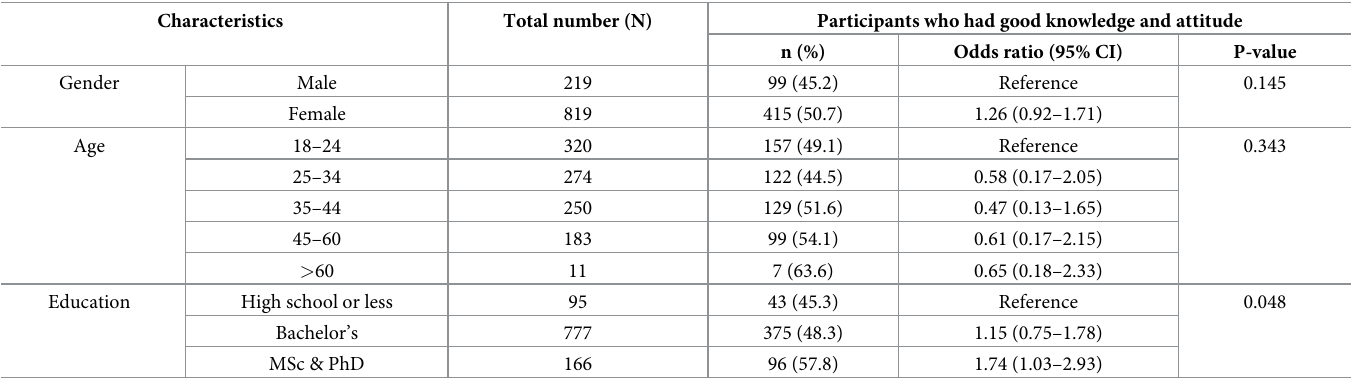
Table 3. Multiple regression analysis of the impact of sociodemographic variables on knowledge and attitude of respondents regarding food additives (n = 1038).